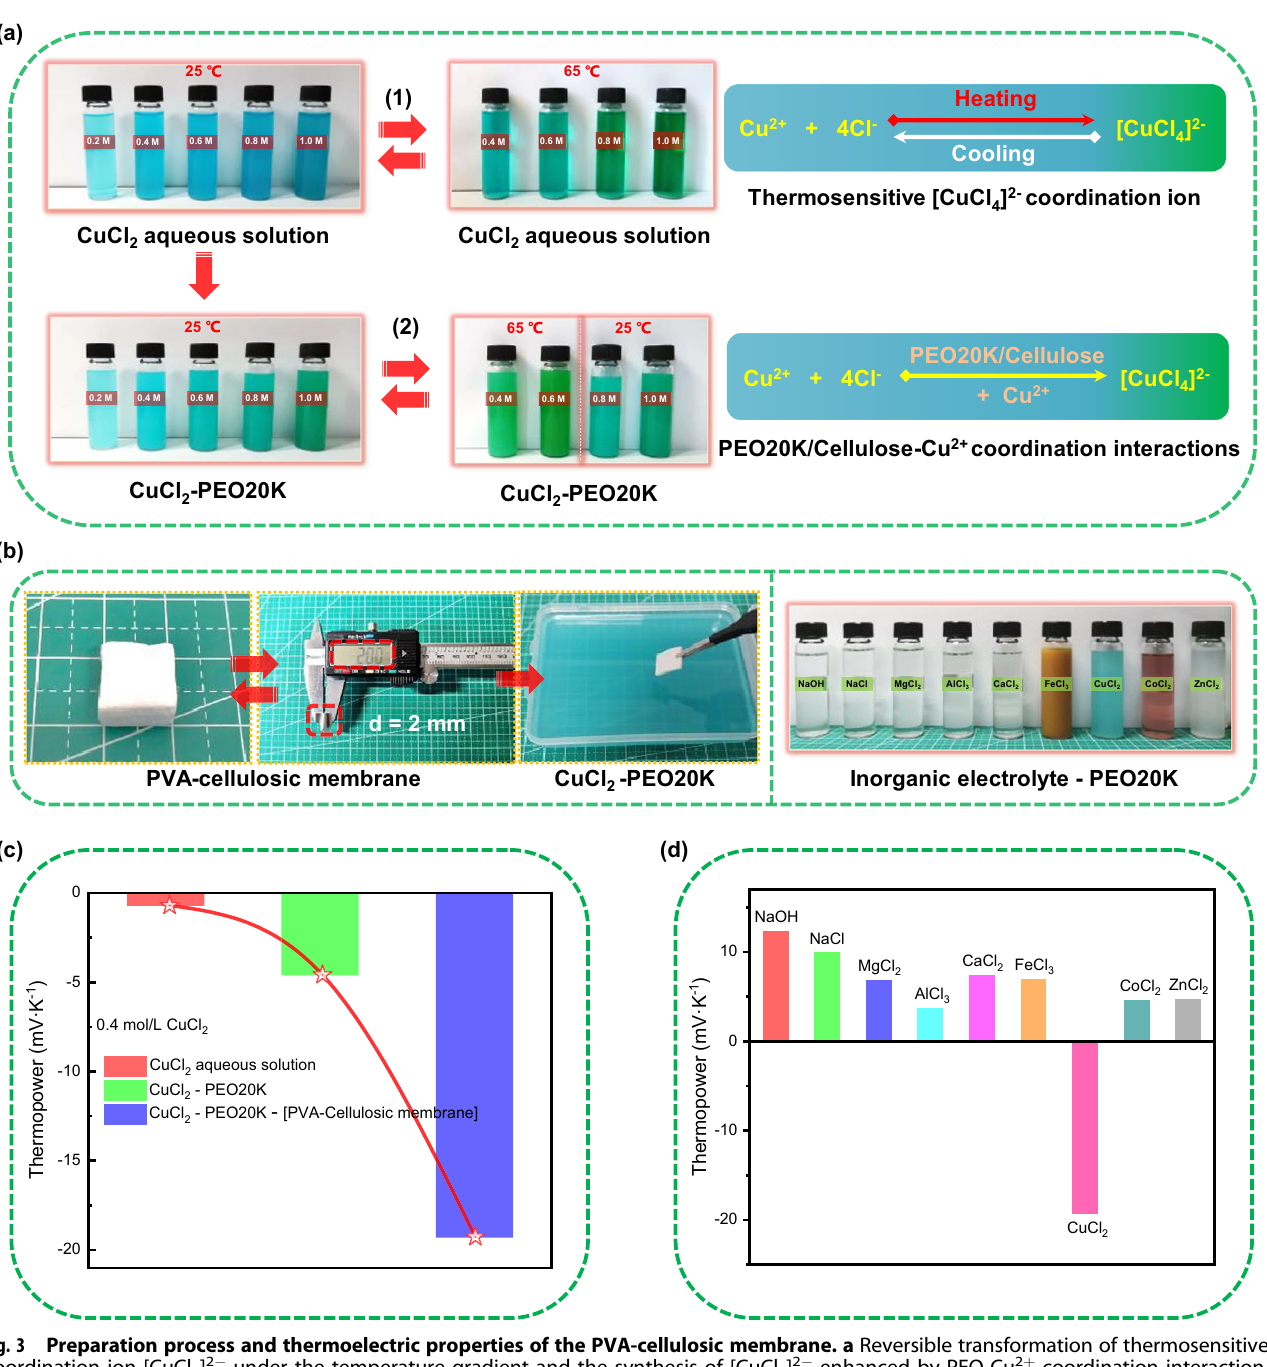
Fig. 3 Preparation process and thermoelectric properties of the PVA-cellulosic membrane. a Reversible transformation of thermosensitive coordination ion [CuCl 4 ] 2 − under the temperature gradient and the synthesis of [CuCl 4 ] 2 − enhanced by PEO-Cu 2 + coordination interaction. b Preparation of polymer electrolytes and in fi ltration of PVA-cellulosic membranes. c Measured thermopowers of CuCl 2 aqueous solution (0.4 mol/L), CuCl 2 -PEO aqueous solution and PVA-cellulosic membrane in fi ltrated with PEO aqueous solution of CuCl 2 . d Measured thermopowers of PVA-cellulosic membranes in fi ltrated with PEO aqueous solution of different inorganic electrolyte (NaOH, NaCl, MgCl 2 , AlCl 3 , CaCl 2 , FeCl 3 , CuCl 2 , CoCl 2 and ZnCl 2 ion transport heat of [CuCl 4 ] 2 − than Cu 2 + in the PVA-cellulosic of CuCl 2 , CaCl 2 or ZnCl 2 based on molecular dynamics simulations membrane in fi ltrated by CuCl 2 electrolyte is the most important can indirectly supplement this point 26 . They pointed out that factor to realize the negative thermopower. The more [CuCl 4 ] 2 − [CuCl 4 ] 2 − had a larger diffusion coef fi cient than Cu 2 + , while the synthesis caused by the coordination of PEO or cellulose with Cu 2 + is an effective means to further amplify the negative of Ca 2 + or Zn 2 + . Moreover, they also emphasized that the thermopower. At present, we have not been able to give a more diffusion rate of metal ion chloride complexes was determined by precise means of proving the higher ion transport heat of their hydration structure. Because for symmetrical electrolyte [CuCl 4 ] 2 − than Cu 2 + . However, the report about aqueous solutions